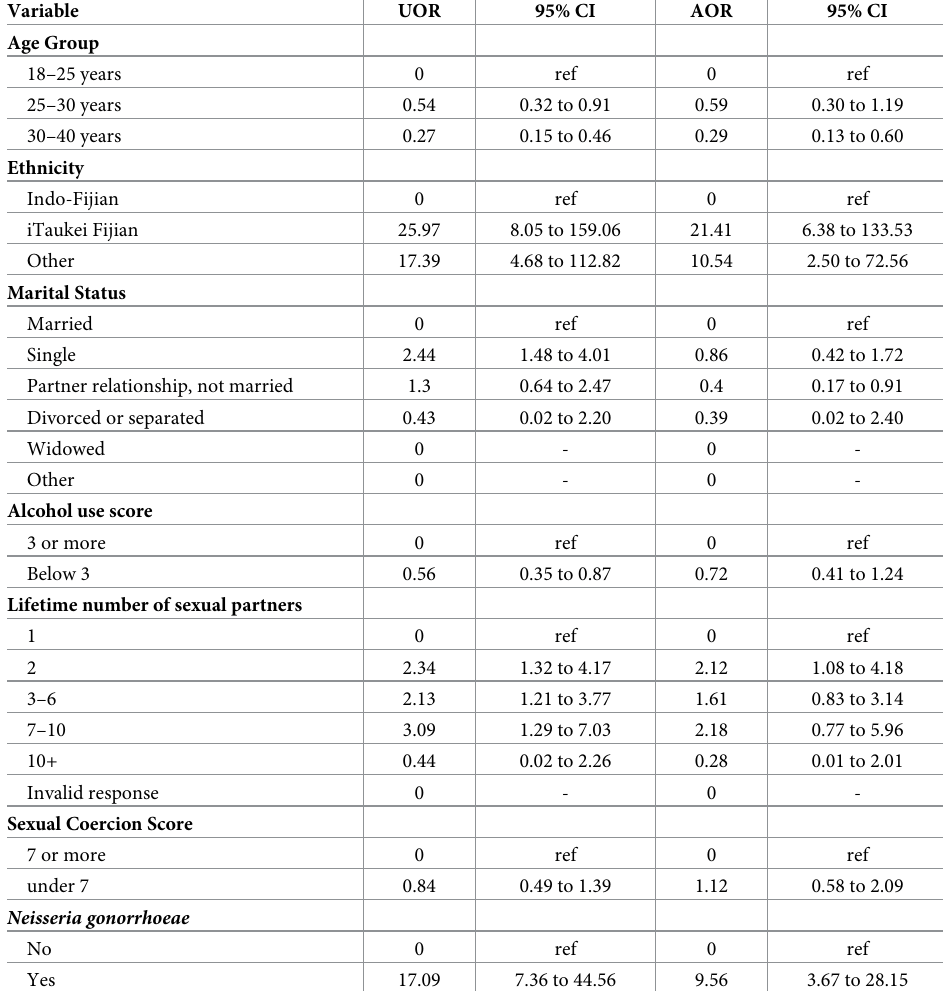
Islanders, European, Caucasian and mixed Pacific Islanders with other